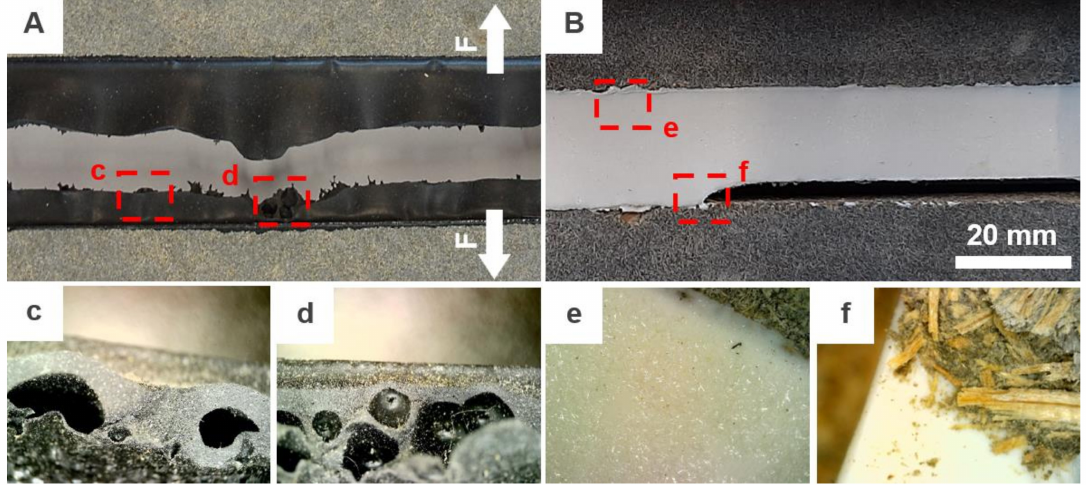
Figure 5. Unusual defects of ( A ) PU / 2 and ( B ) MS / 2 / 1 sealants: ( A ) premature cohesive failure of PU / 2 after elongation to max. 100% with ( C ) and ( D ) typical formation of bubbles within the sealant mass; ( B ) adhesive failure of MS / 2 / 1 with ( E ) unusual crystal-like growth e ff ect and ( F ) partial